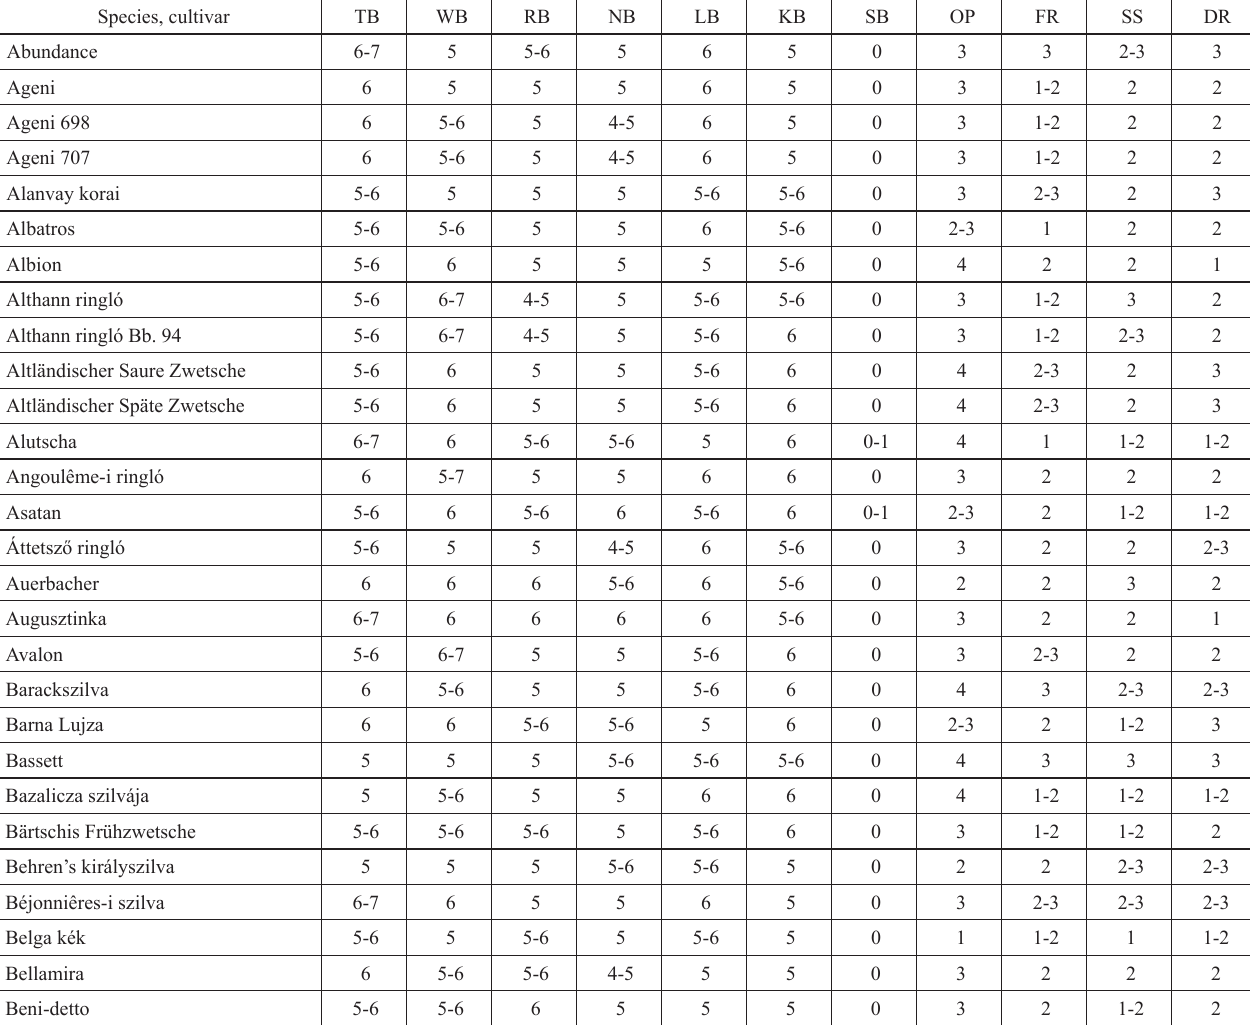
Table 1. Relative ecological indicator values of plum